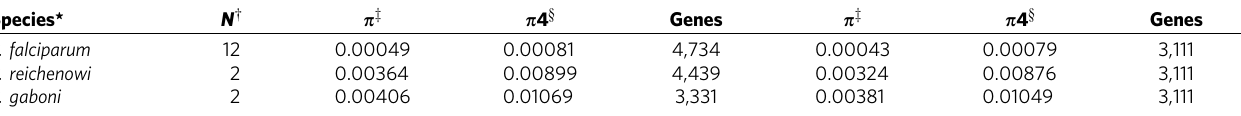
*Values represent mean values across genes, weighted by the number of sites in the gene. Values at the right are for 3,111 genes available for all three species, with the same set of sites used for each. w Number of strains.